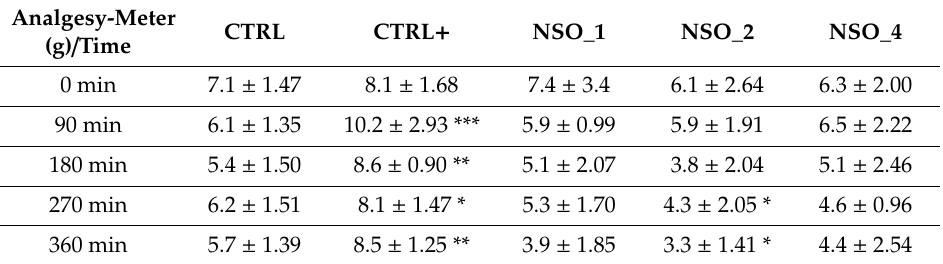
Table 5. Antinociceptive e ff ect of NSO on acute